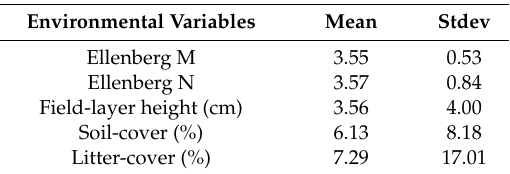
Table A1. Mean values and standard deviations (stdev) for the environmental variables, measured in 4 m ˆ 4 m plots belonging to the validation subset ( n =